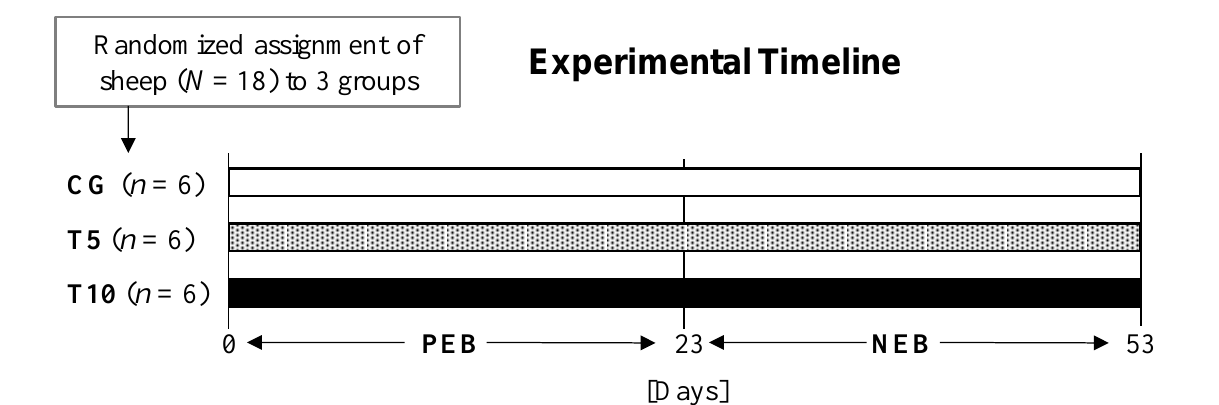
Figure 1. Experimental design and timeline. CG: Control group, T5 and T10: Thiamine treatment groups given a dose of 5 mg/kg and 10 mg/kg, respectively.